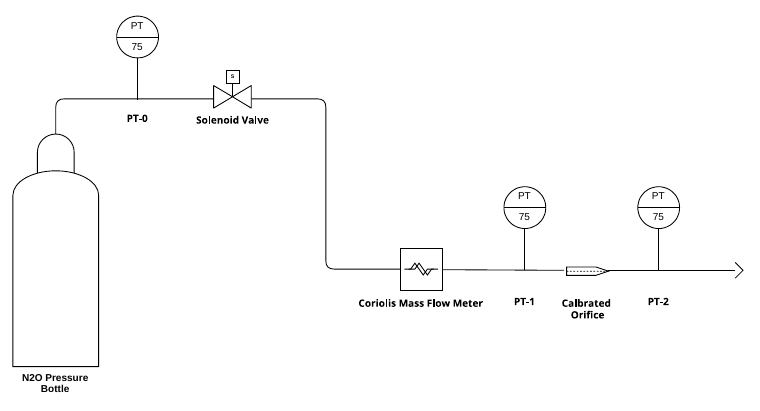
Figure 5. Experimental setup 2 P&ID Diagram, configuration for a vapor drain